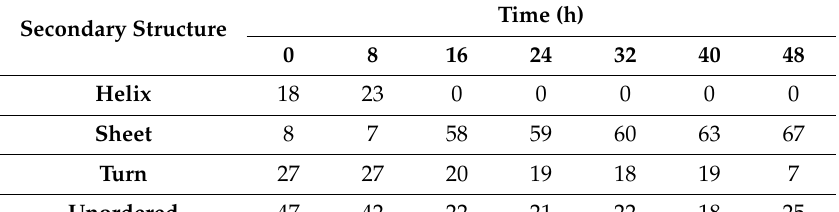
Table 1. Secondary structure analysis of CD data shown in Figure 4. Data were fitted using CONTINLL with basis set 8 in Olis GlobalWorks. The percentages of α -helix, β -sheet, turn, and random coil content are shown.